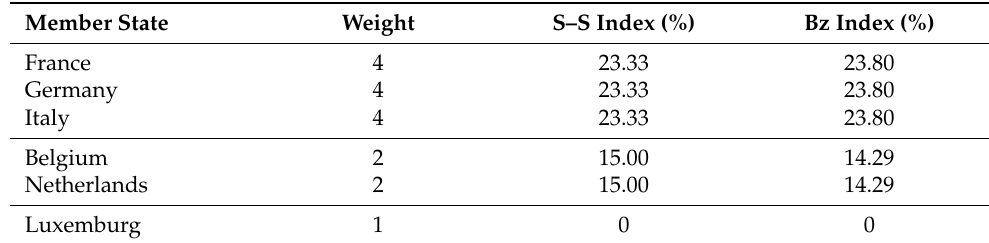
Table 1. Decision-making in the Council of Ministers in 1958, Shapley–Shubik (S–S) and Banzhaf (Bz) indices.